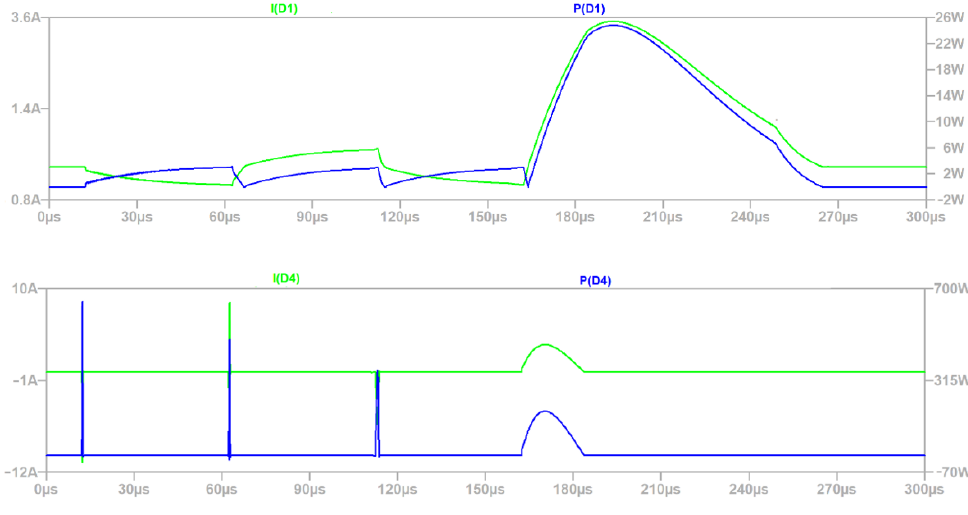
Figure 9. Power and current waveforms of GDT.